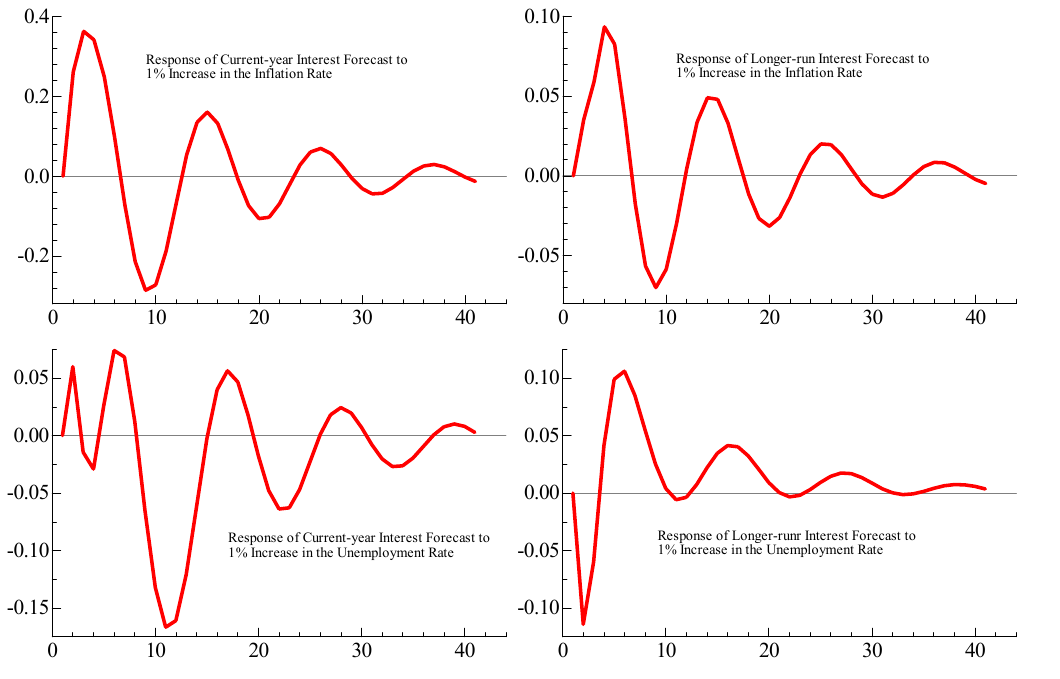
Figure A7. Response of current-year and longer-run forecasts of interest rates to a one percentage point increase in Recorded Inflation and Unemployment rates.